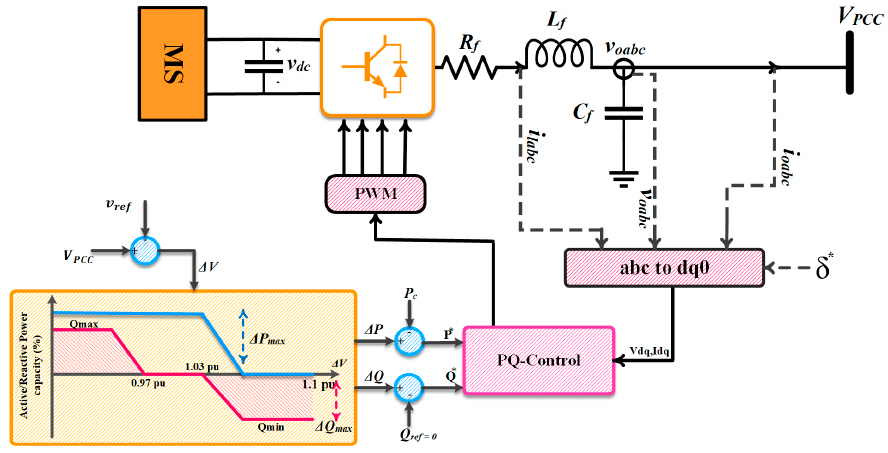
Figure 6. Sample smart inverter volt–var/watt control for the CVR purpose